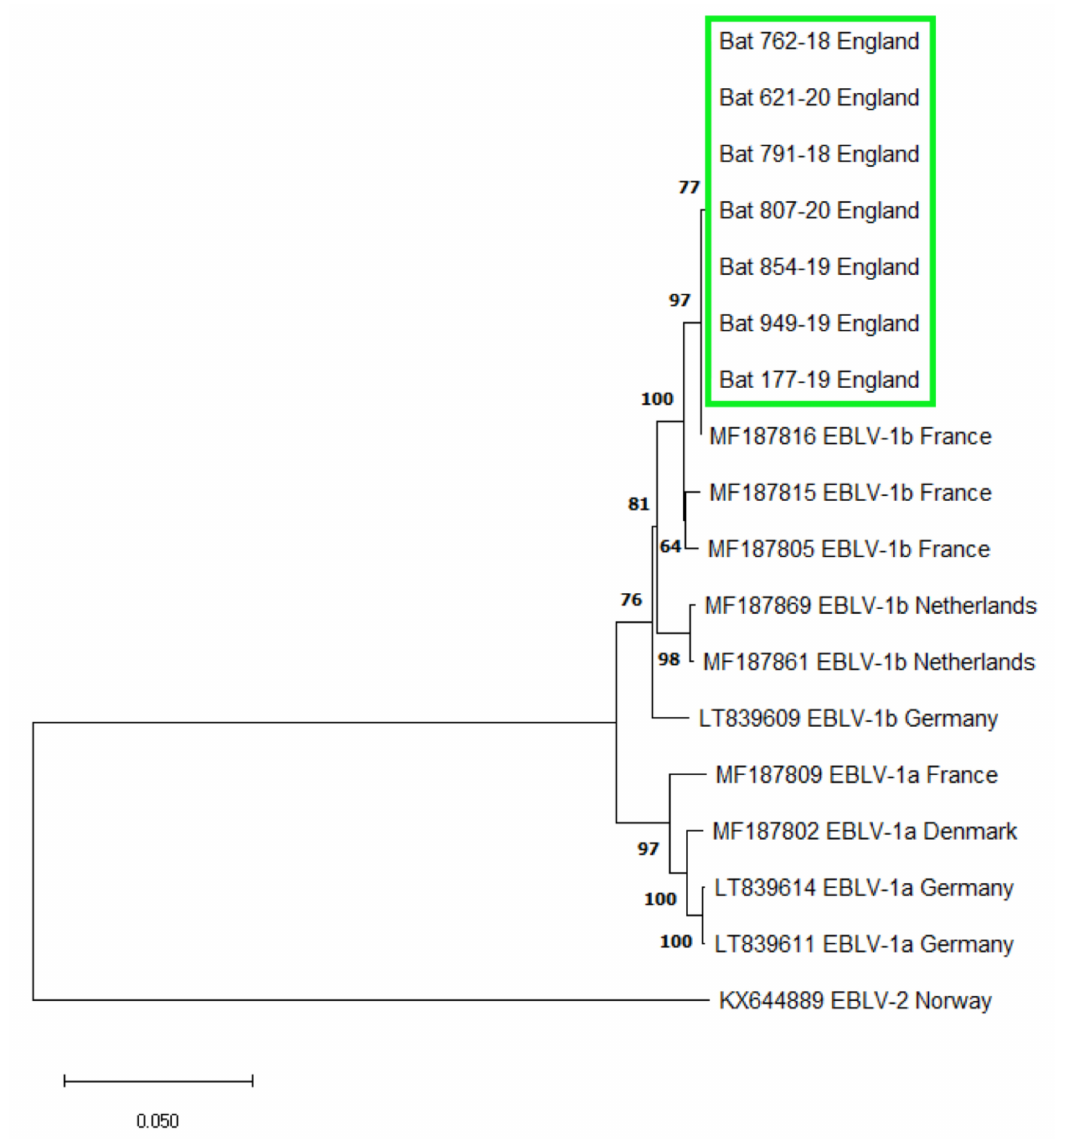
Figure 2. Maximum likelihood phylogeny of seven EBLV-1 detections in the UK (highlighted green), based on 405 bp region of the nucleoprotein gene (nucleotide position 55–459 of the rabies virus genome (Pasteur strain)). The phylogeny includes representative EBLV-1a and EBLV-1b isolates including their Genbank accession number and country of origin. All seven sequences form a well-supported clade with EBLV-1b sequences from France. Node labels represent bootstrap values and scale bar represents substitutions per